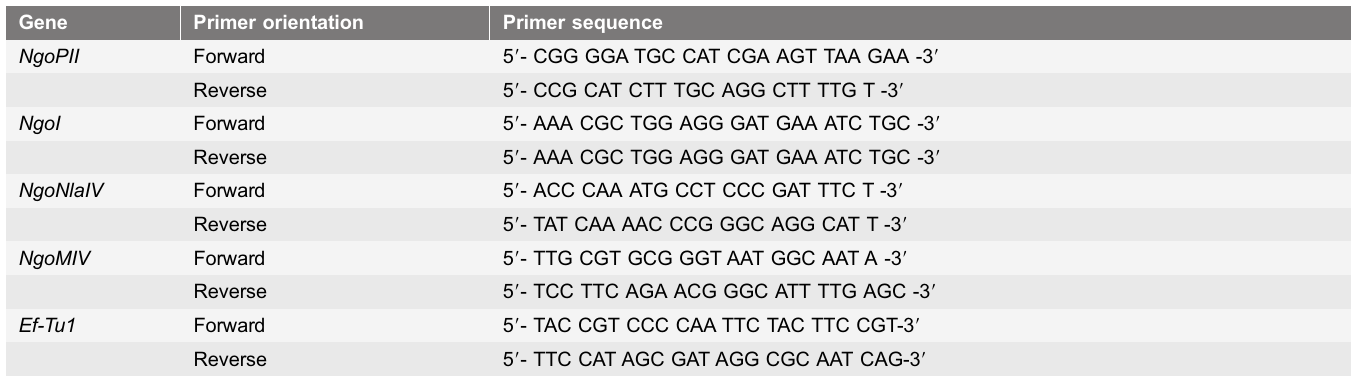
Table 1. Primer sequences used for detection of bacterial genes by